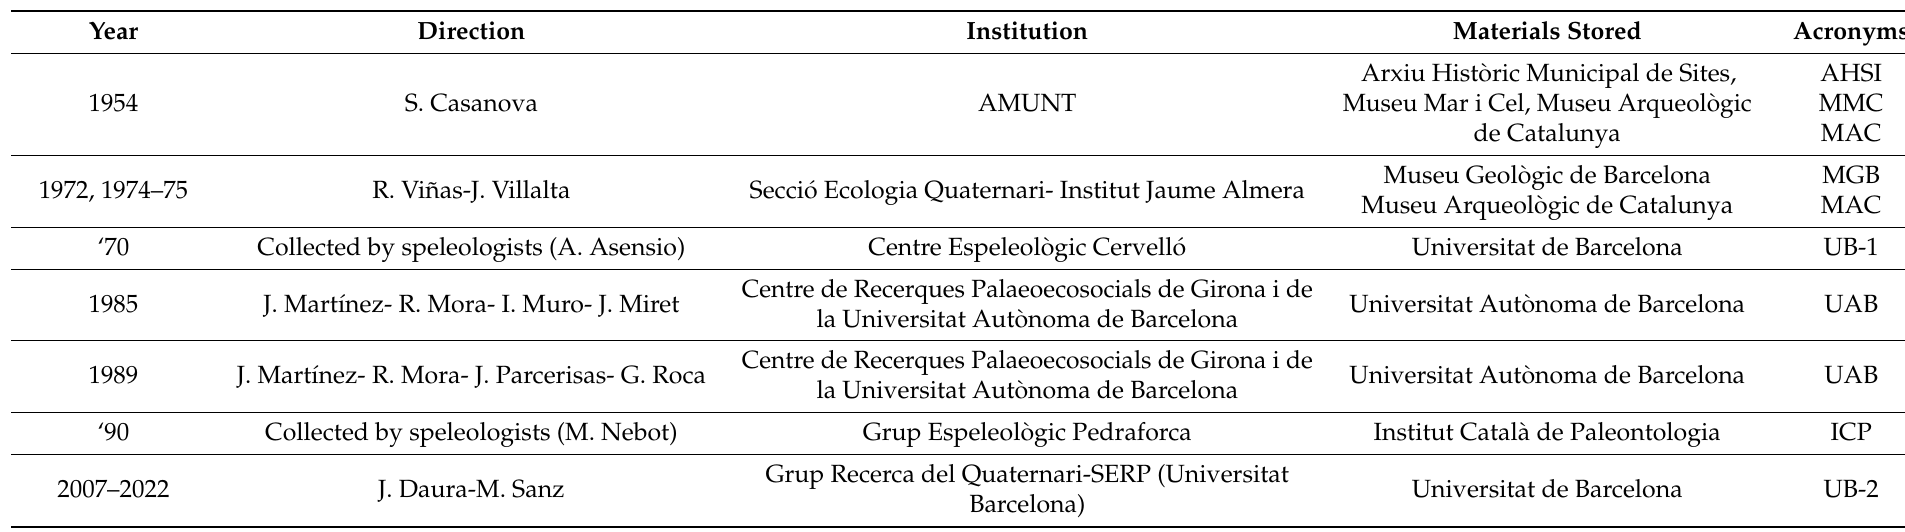
Table 1. Information summarising excavations conducted at